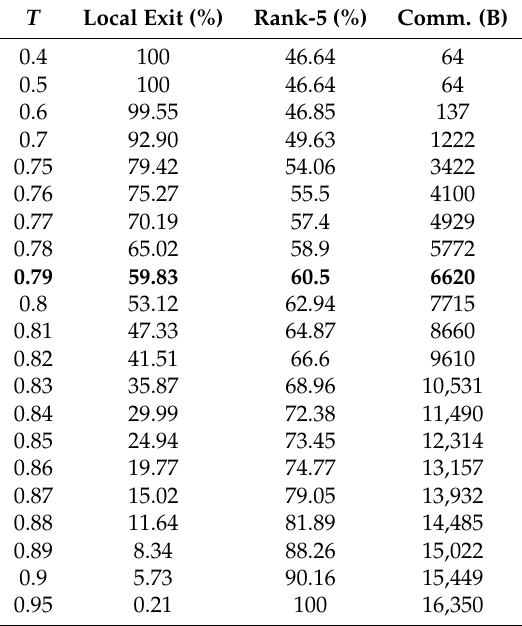
Table 3. While local network L = 10, the effects of different exit thresholds ( T ) settings for the local. T = 0.79 is used in L = 10.